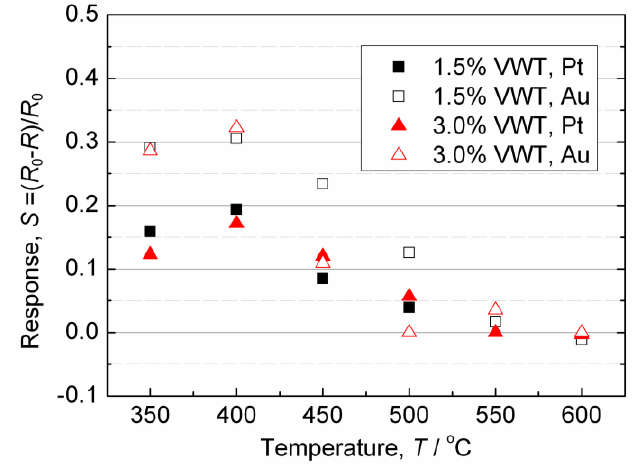
Figure 3. Relationship between the response value, S , of the sensor resistance to 200 ppm SO and the operating temperature. 2